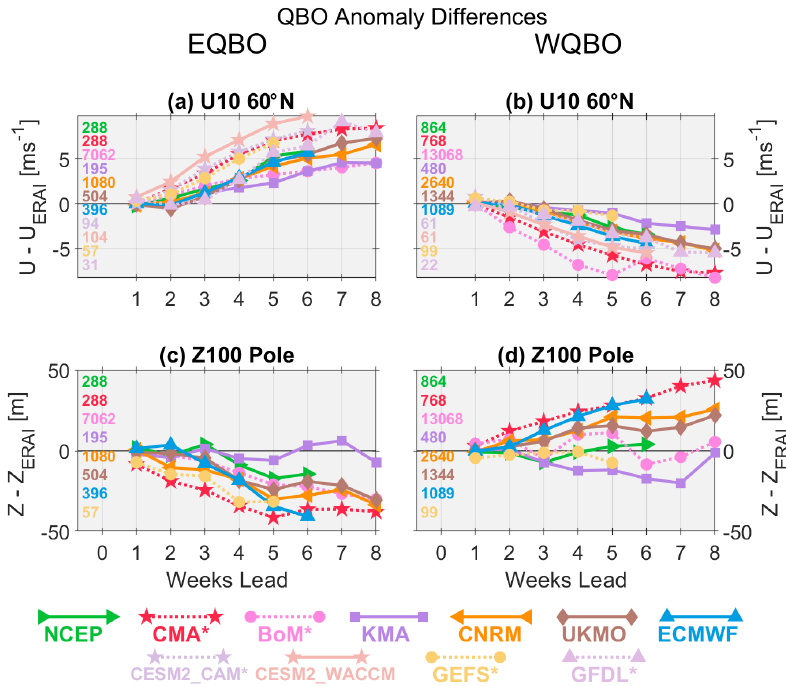
Figure 4. As in Fig. 3 but for polar stratospheric quantities in QBO composites based on the initial 50hPa winds from November and December initializations, including (a, b) zonal-mean zonal wind at 10hPa, 60 ◦ N, and (c, d) 100hPa, 70–90 ◦ N polar cap geopotential heights ( Z 100). The numbers of initializations in the composites are shown in each